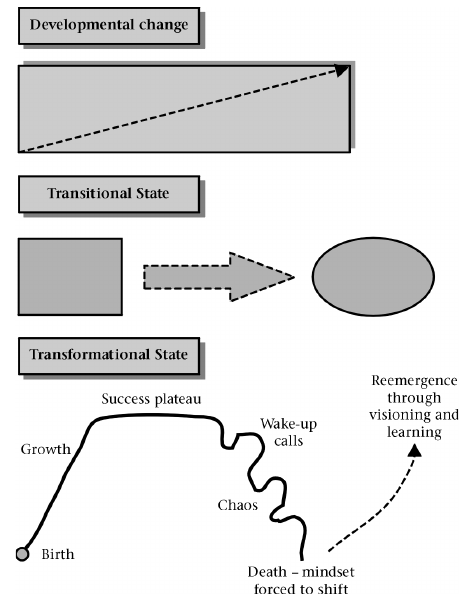
Figure 2: Three Types of